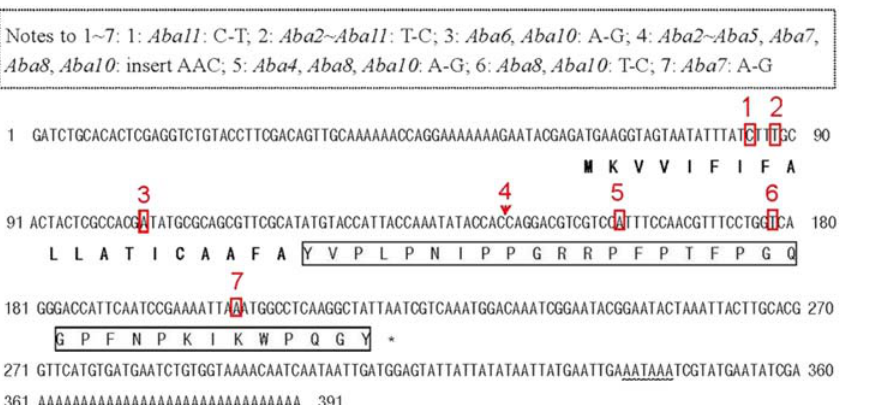
Figure 3. Nucleotide sequence and predicted amino acid sequence of Abaecin1 (GenBank Accession EU714043). The putative signal peptide is bolded, and the mature peptide is indicated by an open box. The translational signal (TAA) is indicated by the star symbol. Restriction and poly (A) adenylation signals (AATAAA) are indicated by a wavy line. The variant loci are boxed or indicated in red by a short arrow, and numbered in red. The nucleotide substitution sites in the precursor sequences between Abaecin1 and other Abaecin genes are boxed with a dotted line. ‘‘ Abaecin1 , Abaecin11 ’’ is abbreviated to ‘‘ Aba1 , Aba11 ’’.